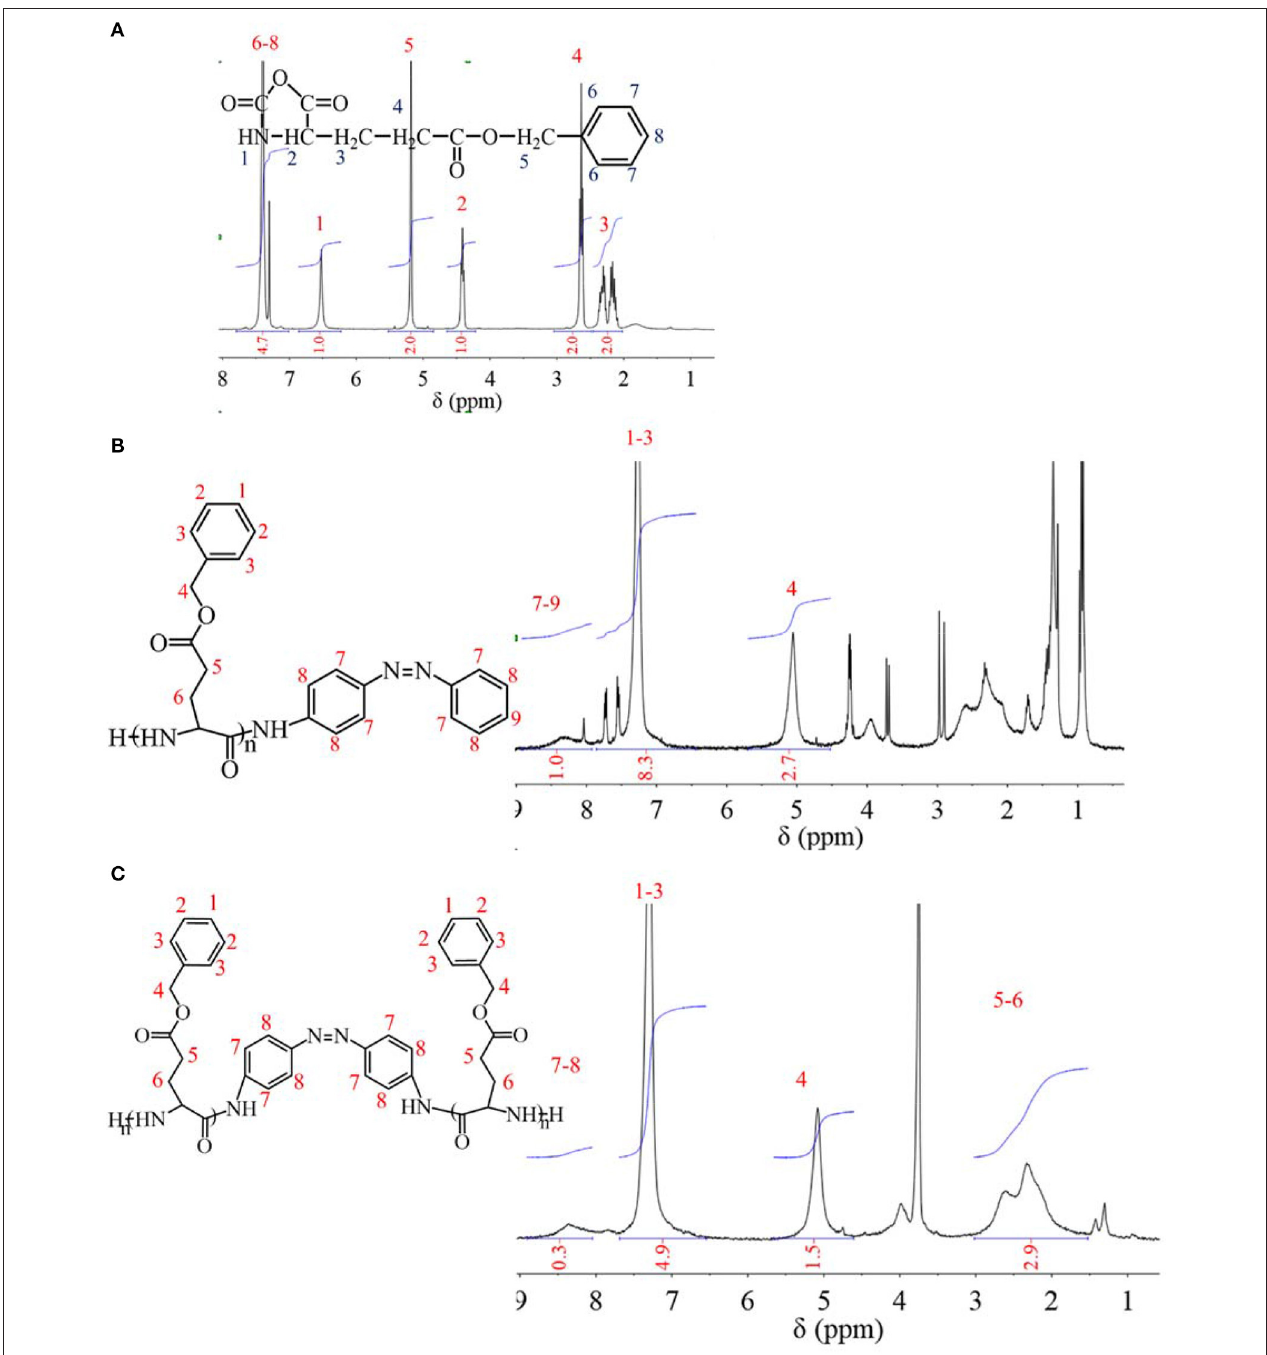
FIGURE 1 | 1 H NMR spectra of (A) BLG-NCA monomer; (B) PBLG1; (C)